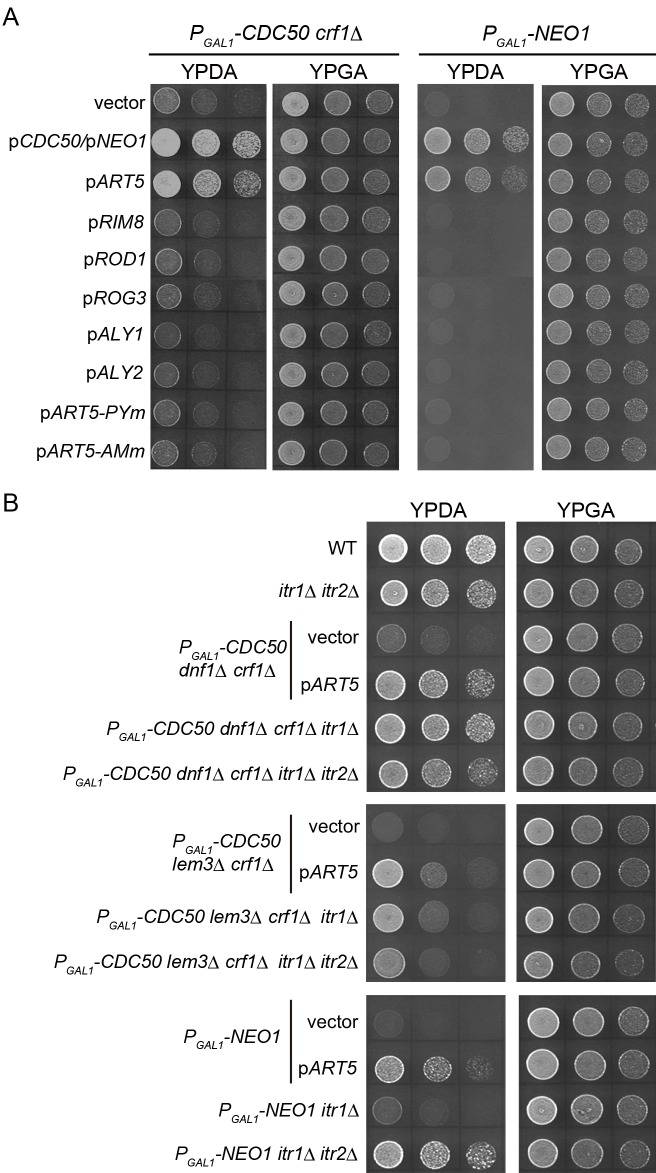
The growth defects of flippase mutants were suppressed by mutations in inositol transporters.(A) Suppression of the flippase mutations by overexpression was specific to ART5. Cell growth was examined as in Fig. 1A, except that the P
GAL1
-CDC50 crf1Δ mutant was incubated at 25°C for 2 days. The strains used were YKT1511 (P
GAL1
-CDC50 crf1Δ) and YKT1932 (P
GAL1
-NEO1), both carrying YEplac195 (vector), pKT1720 (pART5), pKT2135 (pRIM8), pKT2136 (pROD1), pKT2137 (pROG3), pKT1881 (pALY1), pKT1882 (pALY2), pKT2088 (pART5-PYm), or pKT2138 (pART5-AMm). YKT1511 and YKT1932 also carried pKT1263 (pCDC50) and pKT1469 (pNEO1), respectively, as positive controls. (B) Suppression of the growth defects of flippase mutants by mutations in inositol transporters. Cells were pregrown to early log phase in SGA-Ura or YPGA medium, and cell growth was examined as in Fig. 1A. The strains used were YKT1066 (wild type, WT), YKT1866 (itr1Δ itr2Δ), YKT1529 (P
GAL1
-CDC50 dnf1Δ crf1Δ), YKT1934 (P
GAL1
-CDC50 dnf1Δ crf1Δ itr1Δ), YKT1935 (P
GAL1
-CDC50 dnf1Δ crf1Δ itr1Δ itr2Δ), YKT1513 (P
GAL1
-CDC50 lem3Δ crf1Δ), YKT1915 (P
GAL1
-CDC50 lem3Δ crf1Δ itr1Δ), YKT1914 (P
GAL1
-CDC50 lem3Δ crf1Δ itr1Δ itr2Δ), YKT1932 (P
GAL1
-NEO1), YKT1877 (P
GAL1
-NEO1 itr1Δ), and YKT1881 (P
GAL1
-NEO1 itr1Δ itr2Δ). YKT1529, YKT1513, and YKT1932 also carried YEplac195 (vector) or pKT1720 (pART5).